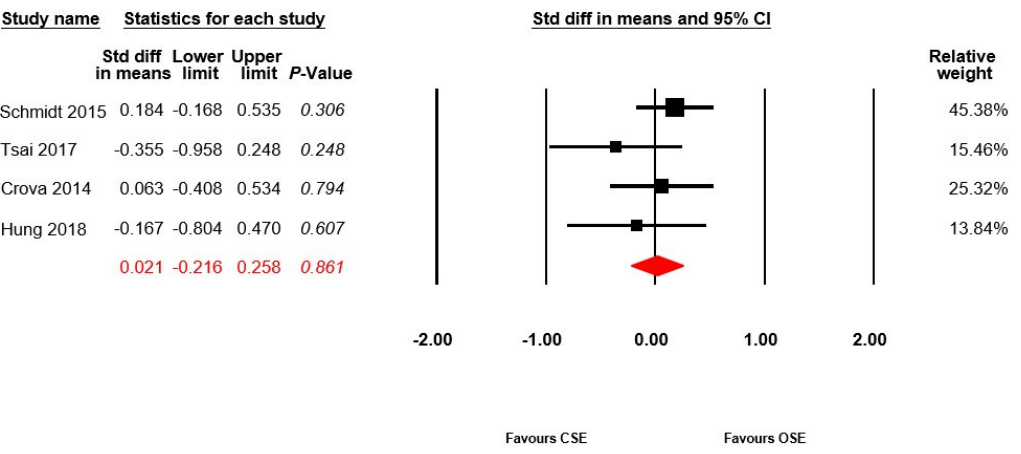
Figure 3. Forest plot for the e ffi cacy of OSE compared to CSE in intervention